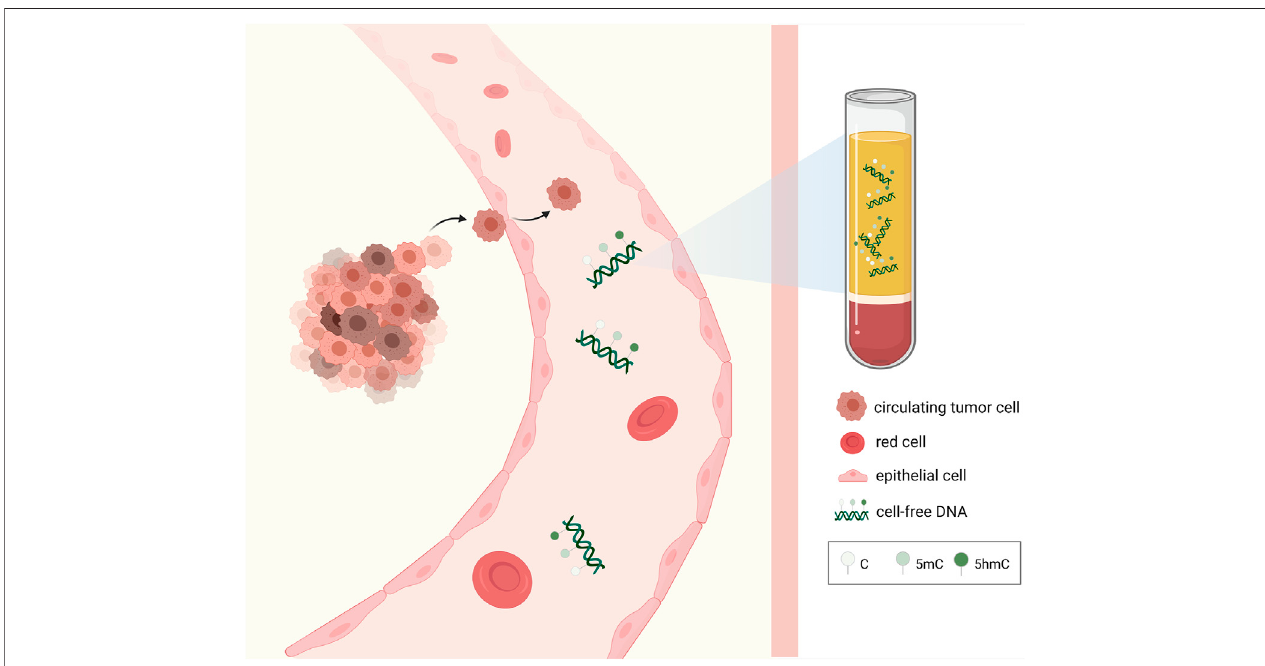
FIGURE 2 | Epigenetic alterations of cell-free DNA extracted from the blood. Tumor-derived epigenetic alterations including 5mC, 5hmC of cfDNA obtained from the blood via liquid biopsy can be utilized as novel biomarkers for cancer diagnosis, prognosis, and treatment.